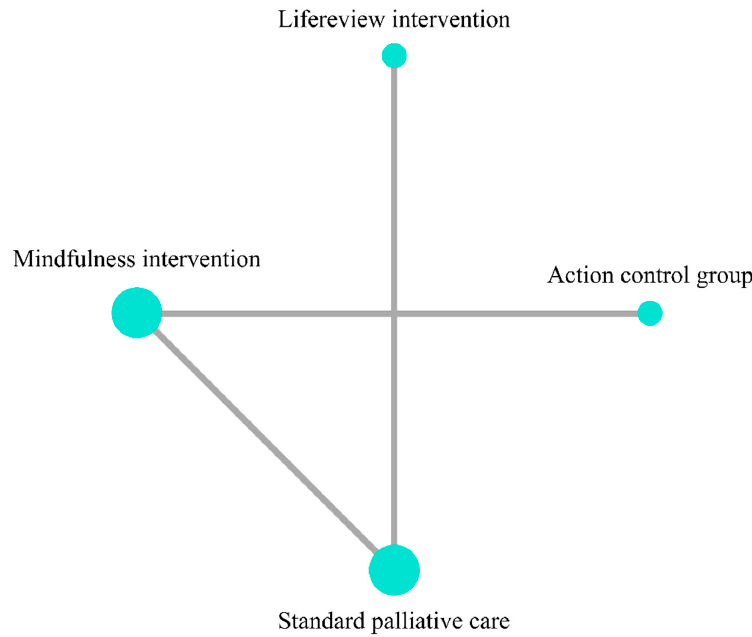
Figure 8. Network plot for outcome of Distress.